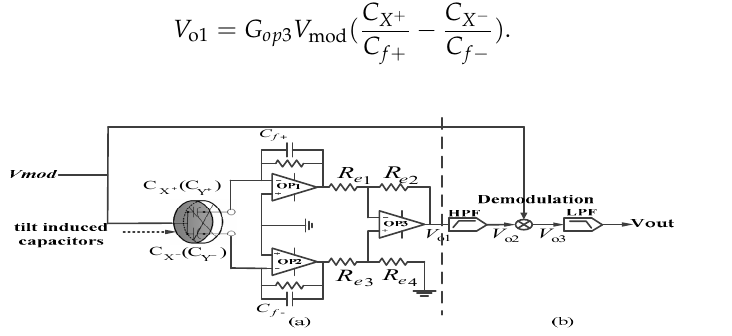
Figure 9. Signal processing system: ( a ) signal detection part; ( b ) signal filtering part.